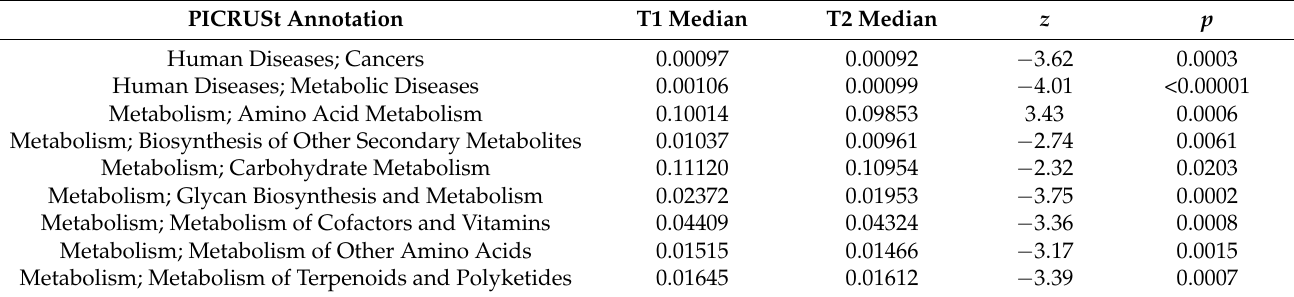
Table 5. PICRUSt functional changes within individual across the intervention. Wilcoxon paired test results for PICRUSt functional annotations across T1 and T2. Phylogenetic Investigation of Communities by Reconstruction of Unobserved States,